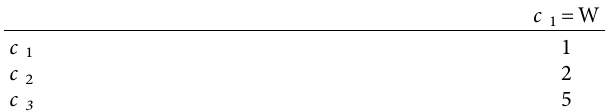
Table 4: Others-to-worst comparison.